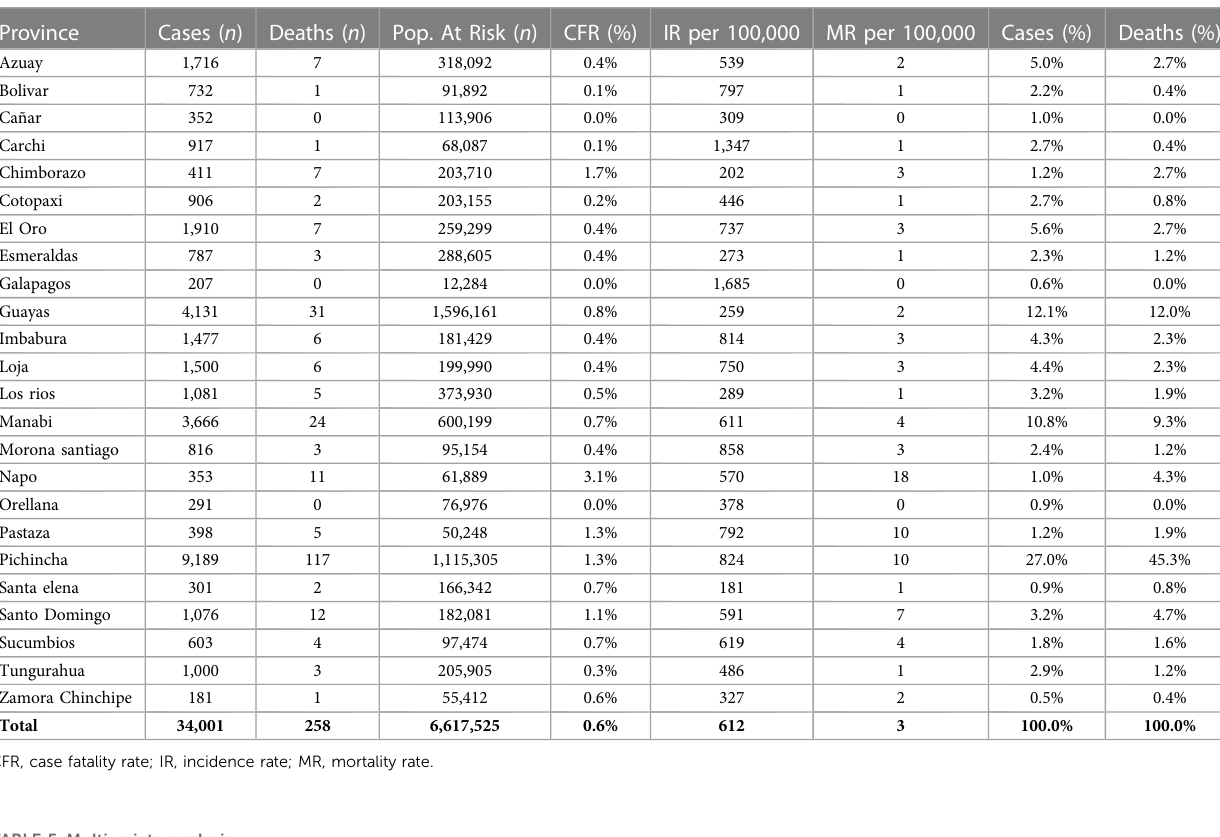
TABLE 5 Multivariate